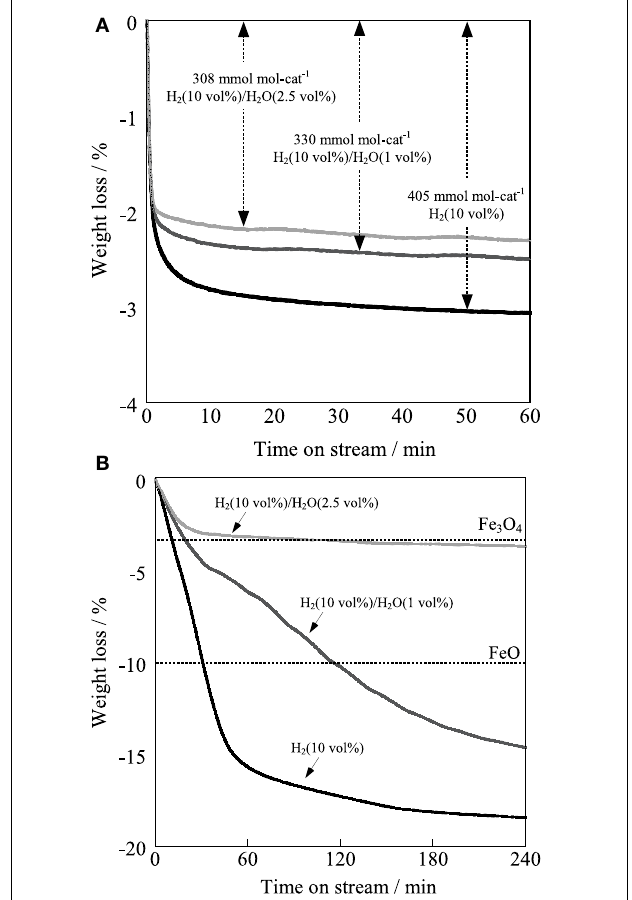
FIGURE 9 | Reduction profiles of (A) Ba 0 . 4 Sr 0 . 6 Fe 0 . 6 Mn 0 . 4 O 3 − δ catalyst and (B) Fe–K catalyst at 783 K under H 2 (10 vol%) atmosphere in the absence of H 2 O, H 2 /H 2 O (10 vol%/1 vol%) atmosphere and H 2 /H 2 O (10 vol%/2.5 vol%)